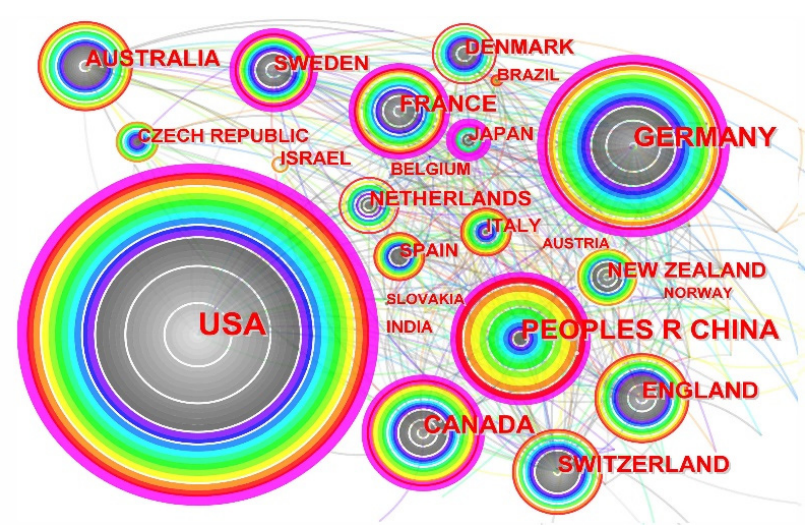
Figure 6. Cooperative network of countries in preferential flow research in the past 30 years.